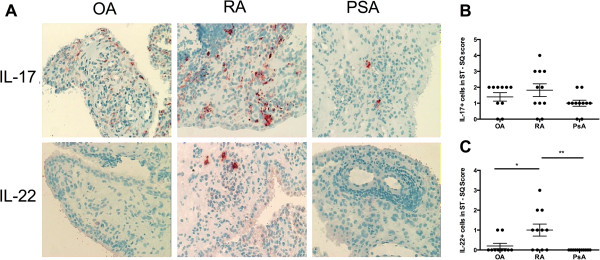
Representative interleukin 17 and interleukin 22 expression patterns in synovial tissue from osteoarthritis, rheumatoid arthritis and psoriatic arthritis patients. (A) Positive cells show red staining; original magnification, ×200. (B) and (C) Semiquantitative (SQ) analysis shows grading of the percentage of cells present in entire tissue: 0 = no staining, 1 = <10%, 2 = 10% to 25%, 3 = 25% to 50% and 4 = >50% for both (B) interleukin 17-positive (IL-17+) and (C) IL-22+ in tissue samples from patients with osteoarthritis (OA), rheumatoid arthritis (RA) and psoriatic arthritis (PsA). * p<0.05, **p<0.01, ***p<0.001.